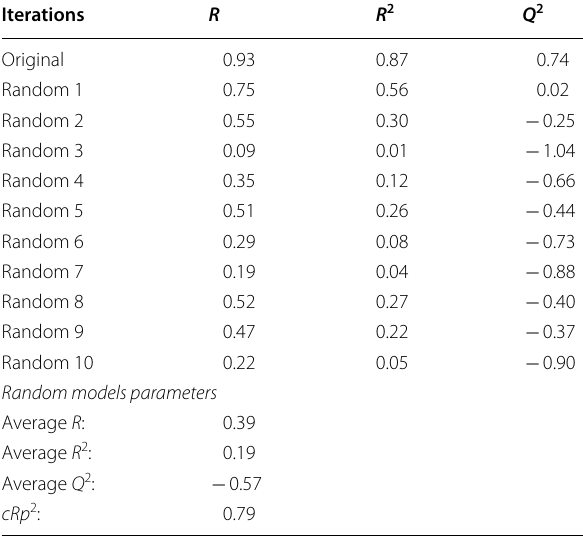
Table 4 Y-randomization test result